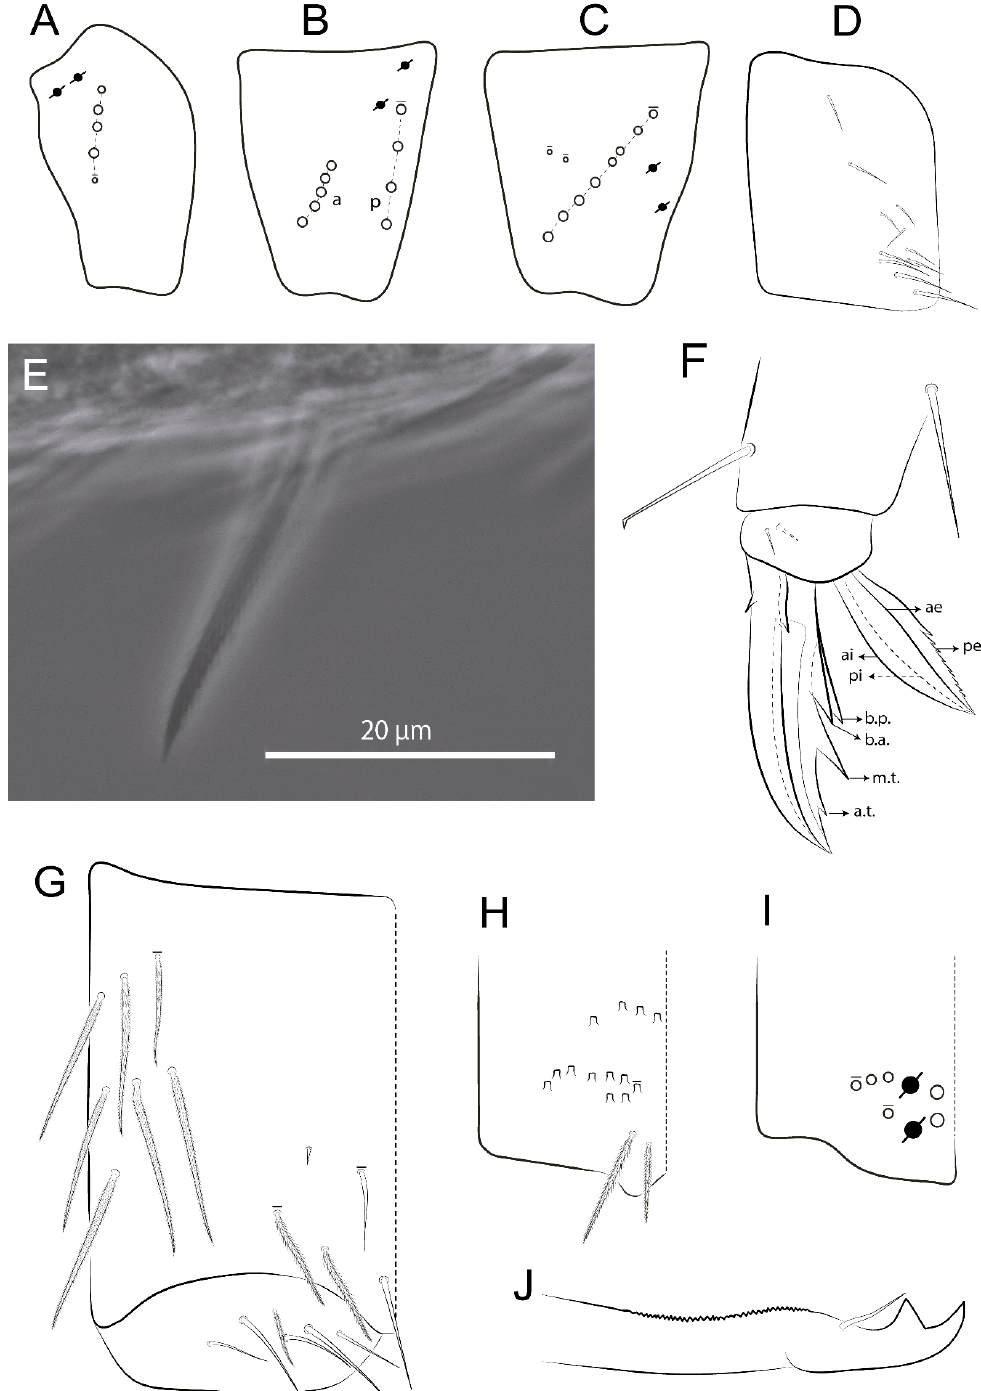
Figure 54. Pseudosinella mitodentunguilata sp. nov.: trunk appendages. ( A–C ) subcoxa I–III, respectively; ( D ) trochanteral organ; ( E ) modified chaeta of tibiotarsus III; ( F ) distal tibiotarsus and empodial complex III (anterior view); (G ) collophore (lateral view); ( H ) distal part of manubrium (ventral view); ( I ) manubrial plate (dorsal view); ( J ) distal dens and mucro (inner view).